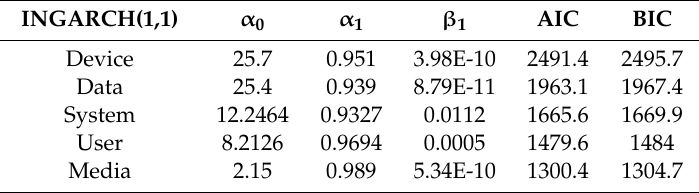
Table 1. Parameter estimates for integer-valued GARCH (1,1)